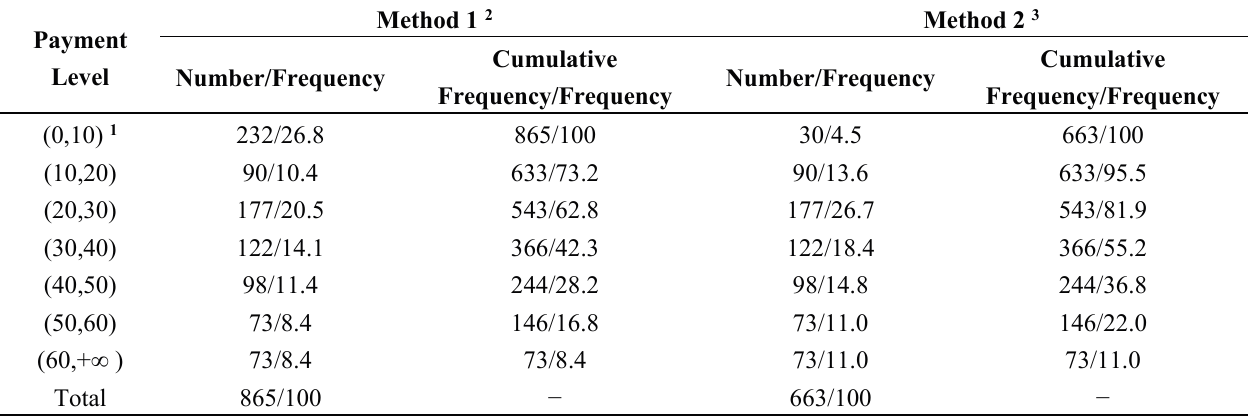
Table 1. The interval distribution of general practitioners by contractual service.